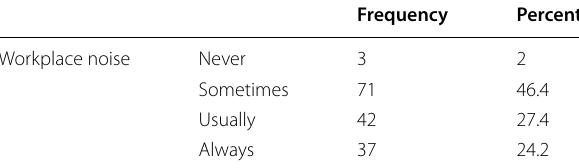
Table 4 Frequency of exposure to noise in the workplace